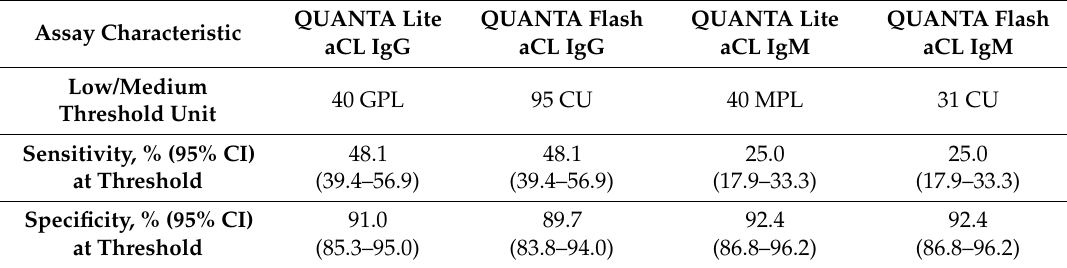
Table 1. Low/medium threshold values, and associated clinical sensitivity and specificity of anticardiolipin (aCL) assays. GPL: IgG Phospholipid; CU: chemiluminescent units; MPL: IgM Phospholipid; CI: confidence interval.